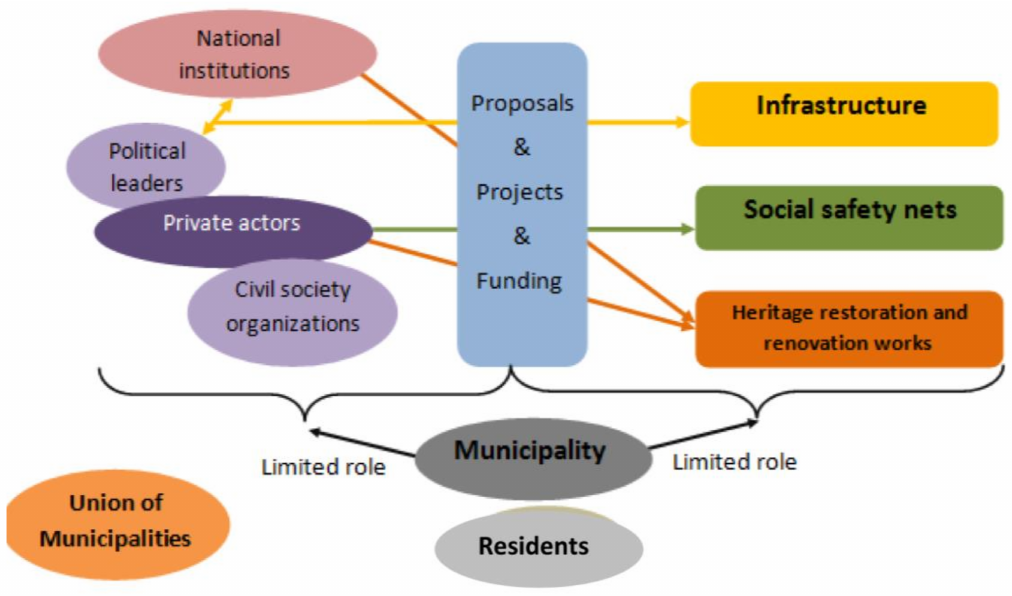
Figure 2. Schematic representing the current process of decision-making in the Saida municipality. Project proposals, their funding and implementation is highly centralized, controlled by national institutions and leadership